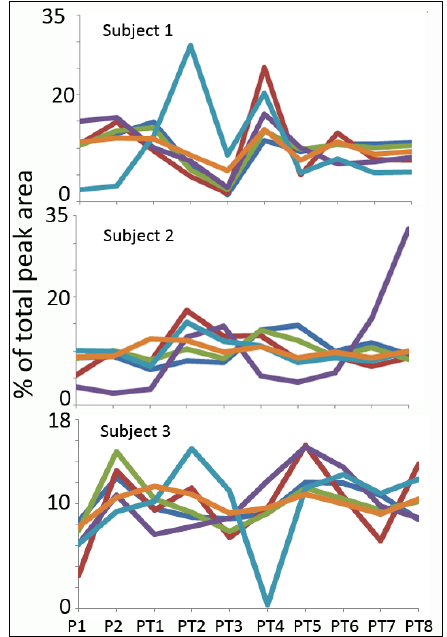
Figure 3. Comparison of the exercise response of the area percentage for MS creatinine (orange) with phenylalanine (red), carnitine (purple), threonine (green), glutamine (dark blue) and the dietary xenobiotic stachydrine (light